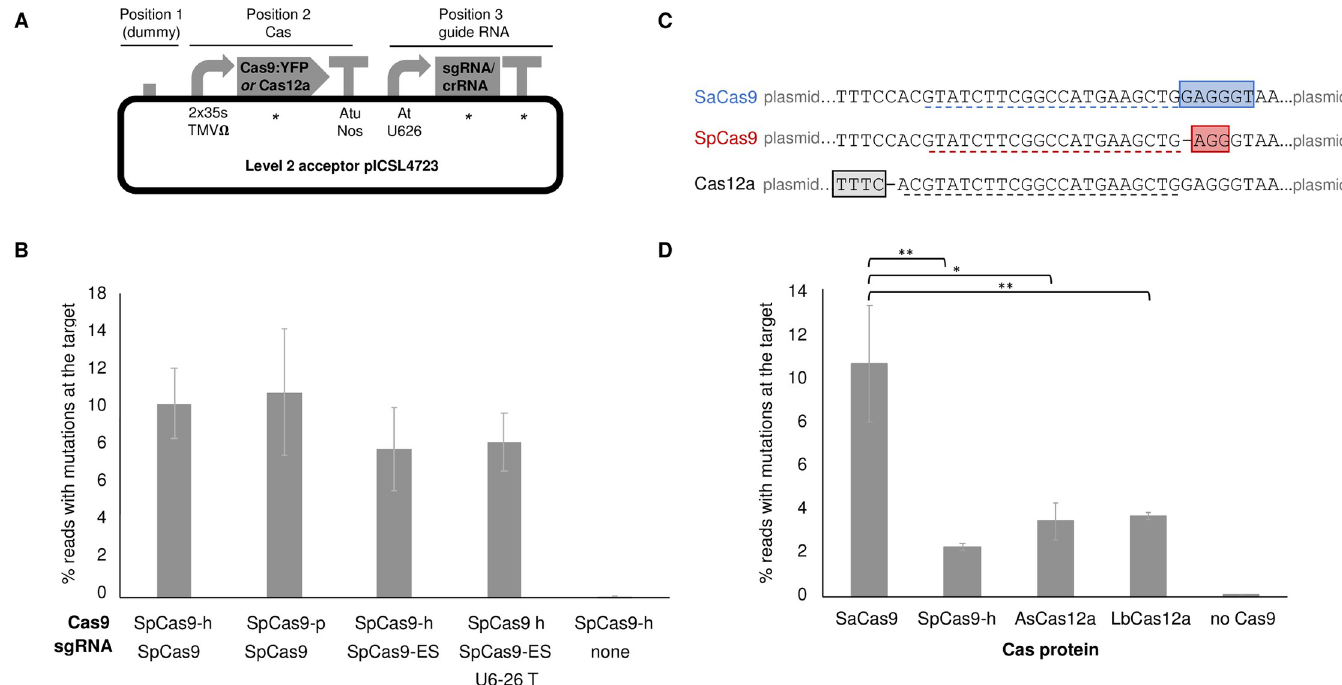
Fig 1. Comparison of Cas9 and Cas12 nucleases at a single target. (A) All constructs were assembled in the same backbone, using the same regulatory elements. Asterisks ( � ) represent elements compared in this study. The ‘dummy’ consists of 15 random nucleotides and enables the Cas9 and sgRNA expression cassettes to be reassembled with, e.g. a selectable marker cassette, in Position 1. (B) Assessment of codon-optimisation and sgRNA scaffold on the efficiency of Cas9-mediated targeted mutagenesis at PDS1 in Nicotiana benthamiana protoplasts (h = human; p = plant; ES = extended stem; T = terminator). (C) An identical target sequence was used to test Cas proteins from different bacteria. The target was flanked by the preferred cognate protospacer adjacent motif (PAM) for SpCas9 (red box), SaCas9 (blue box) or Cas12a (black box). The spacer sequence used in each sgRNA (Cas9) or crRNA (Cas12a) are indicated by dotted lines. (D) Under identical experimental conditions, SaCas9 induced more mutations at the target than SpCas9, AsCas12a or LbCas12a. Error bars = standard error of the mean; n = 4. Post hoc comparisons using Tukey’s Honest Significant Difference test indicted significant differences: � = p < 0.05, �� = p < 0.01.